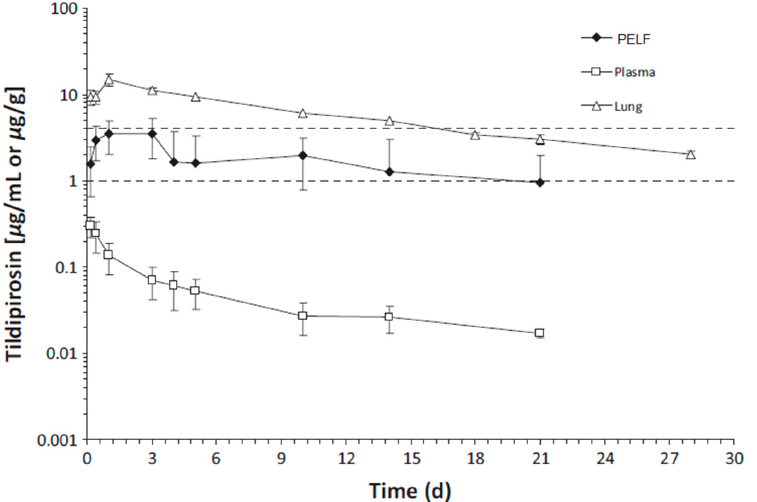
Figure 2. Tildipirosin concentration vs. time (d) in bovine plasma ( µ g/mL), lung tissue, and PELF ( µ g/g) from cattle following a single SC administration at 4 mg/kg body weight. The dotted lines represent the MIC 90 for Mannheimia haemolytica and Pasteurella multocida (1 µ g/mL) and for Histophilus somni (4 µ g/mL) (Modified from [44]). Copyright © 2012 John Wiley & Sons, Inc.